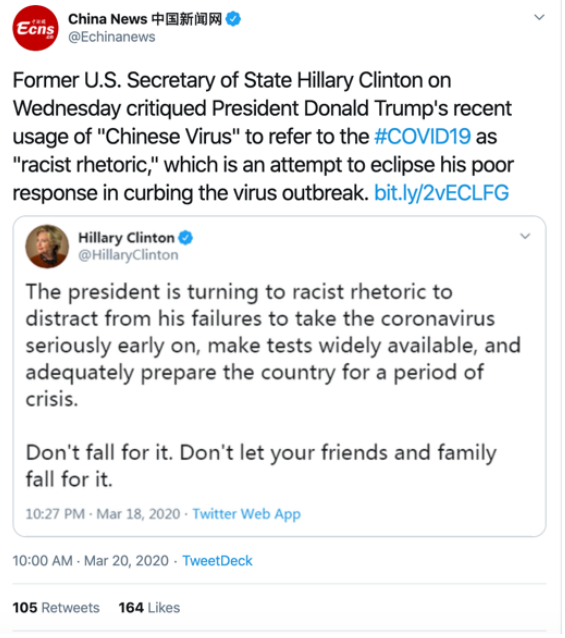
Figure 3. Screenshot of @Echinanews’ tweet. Source: China News (2020).